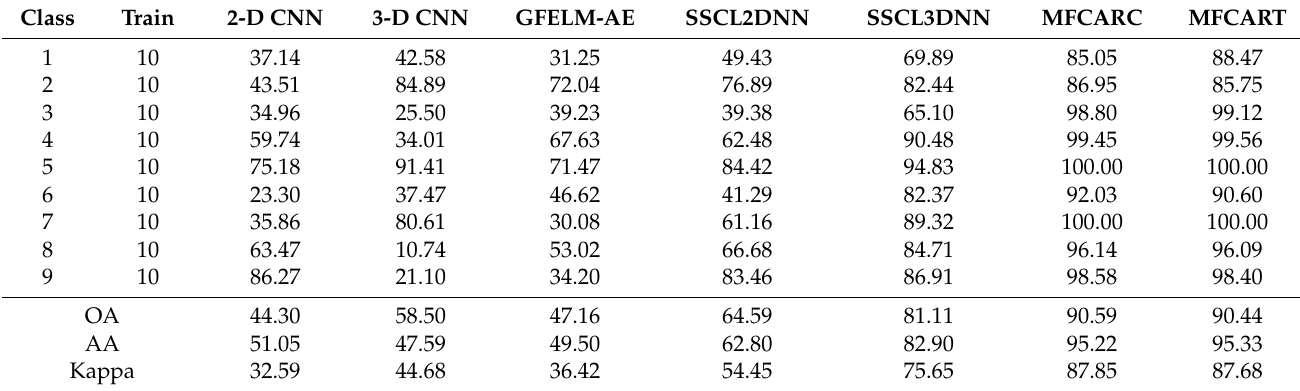
Table 11. Classification performance of different methods over the University of Paiva data set.